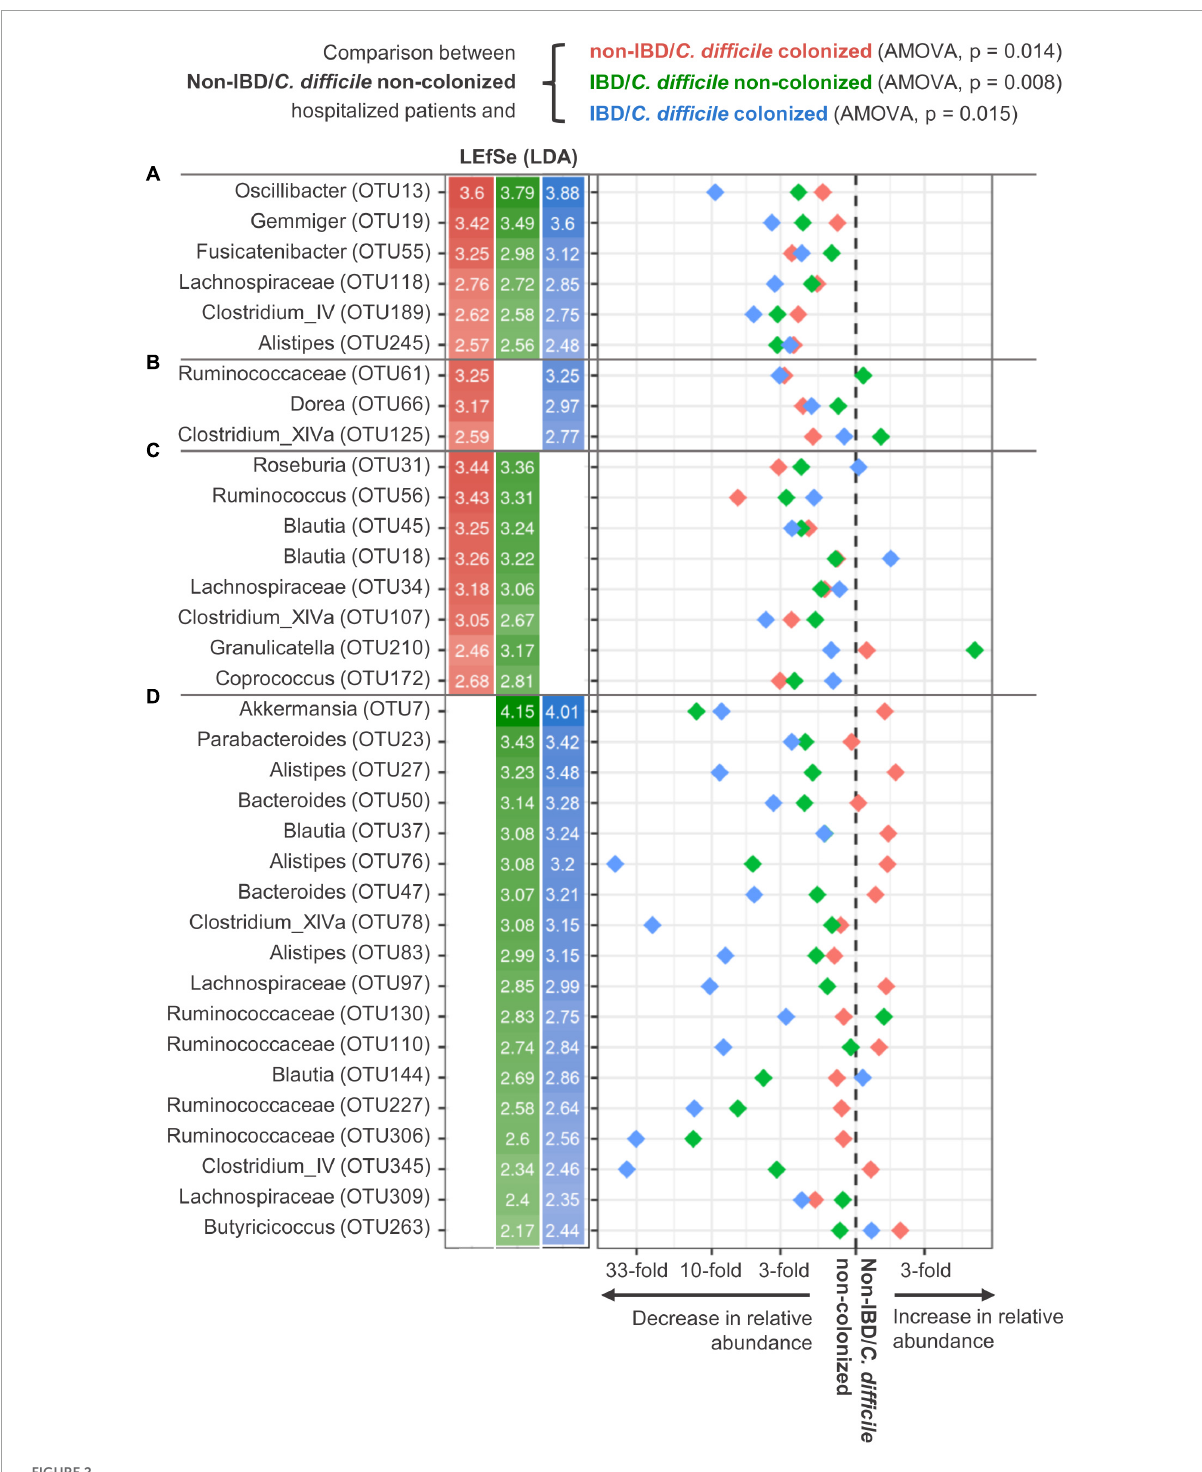
FIGURE2 Shared community characteristics of Clostridioides difficile colonization and inflammatory bowel disease. Four groups were formed based on inflammatory bowel disease (IBD) status and C. difficile colonization. The control group contained C. difficile non-colonized non-IBD patients. For each differentially represented operational taxonomic unit (OTU), the LDA score (LEfSe test, left) and difference in relative abundance (right) for non-IBD/ C. difficile -colonized (red), IBD/ C. difficile- non-colonized (green), and IBD/ C. difficile -colonized patients (blue) as compared to the control group are presented. Sections (A–D) denote OTU groups that are shared among the different patient